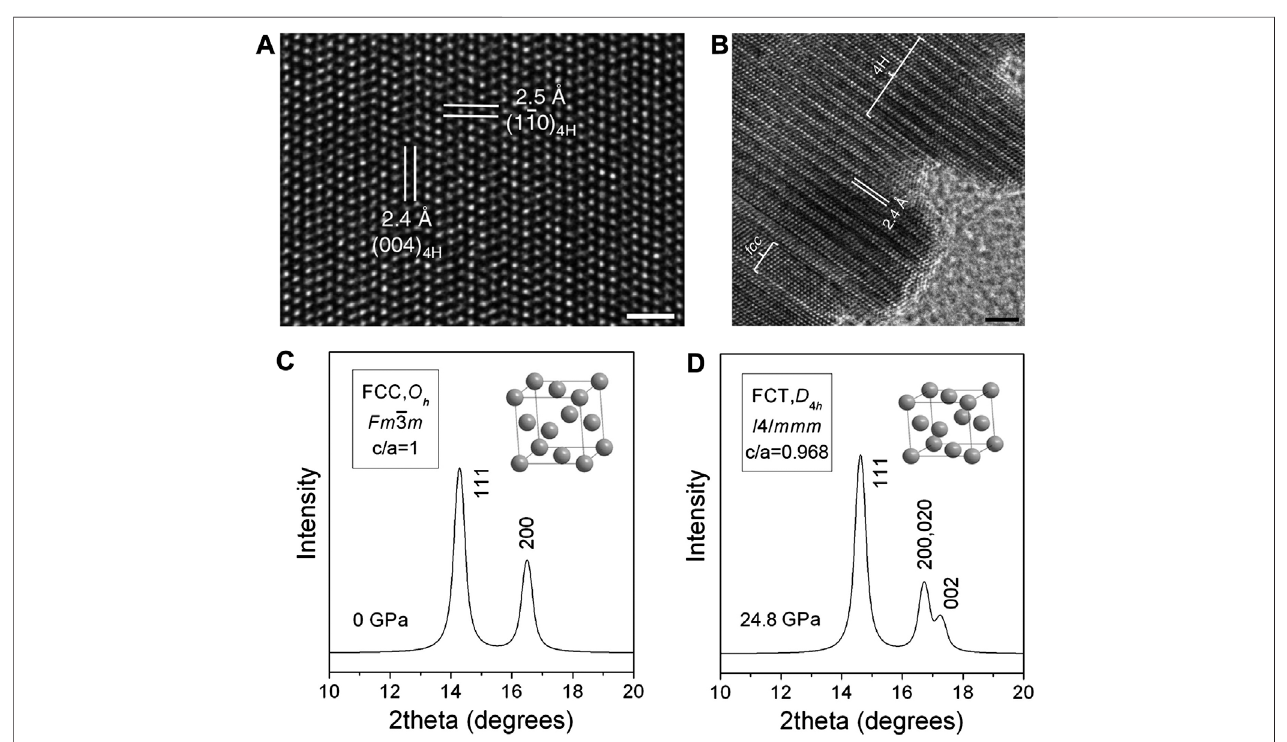
FIGURE 8 | (A) HRTEM image of 4H hexagonal Au nanoribbons (scale bar, 1 nm). (B) Epitaxial growth of Pd crystals on 4H hexagonal Au nanoribbons (scale bar, 2 nm). (C,D) Comparison of XRD patterns of Pd nanocubes before and after compression. (A,B) Reproduced with permission (Fan et al., 2015). Copyright 2015, Springer Nature. (C,D) Reproduced with permission (Guo et al., 2008). Copyright 2008, American Chemical